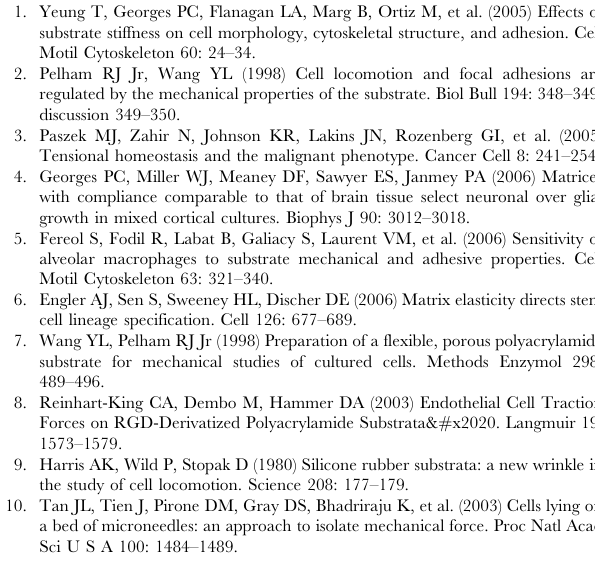
Figure S2 Fiber in fibrin gel are randomly oriented prior to cell